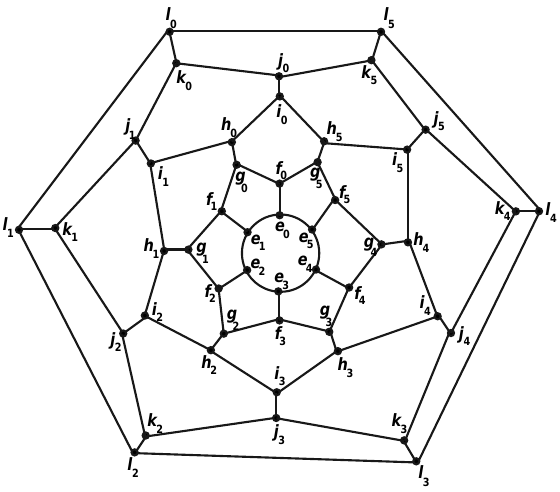
Figure 8. The graph of convex polytope H 6 .